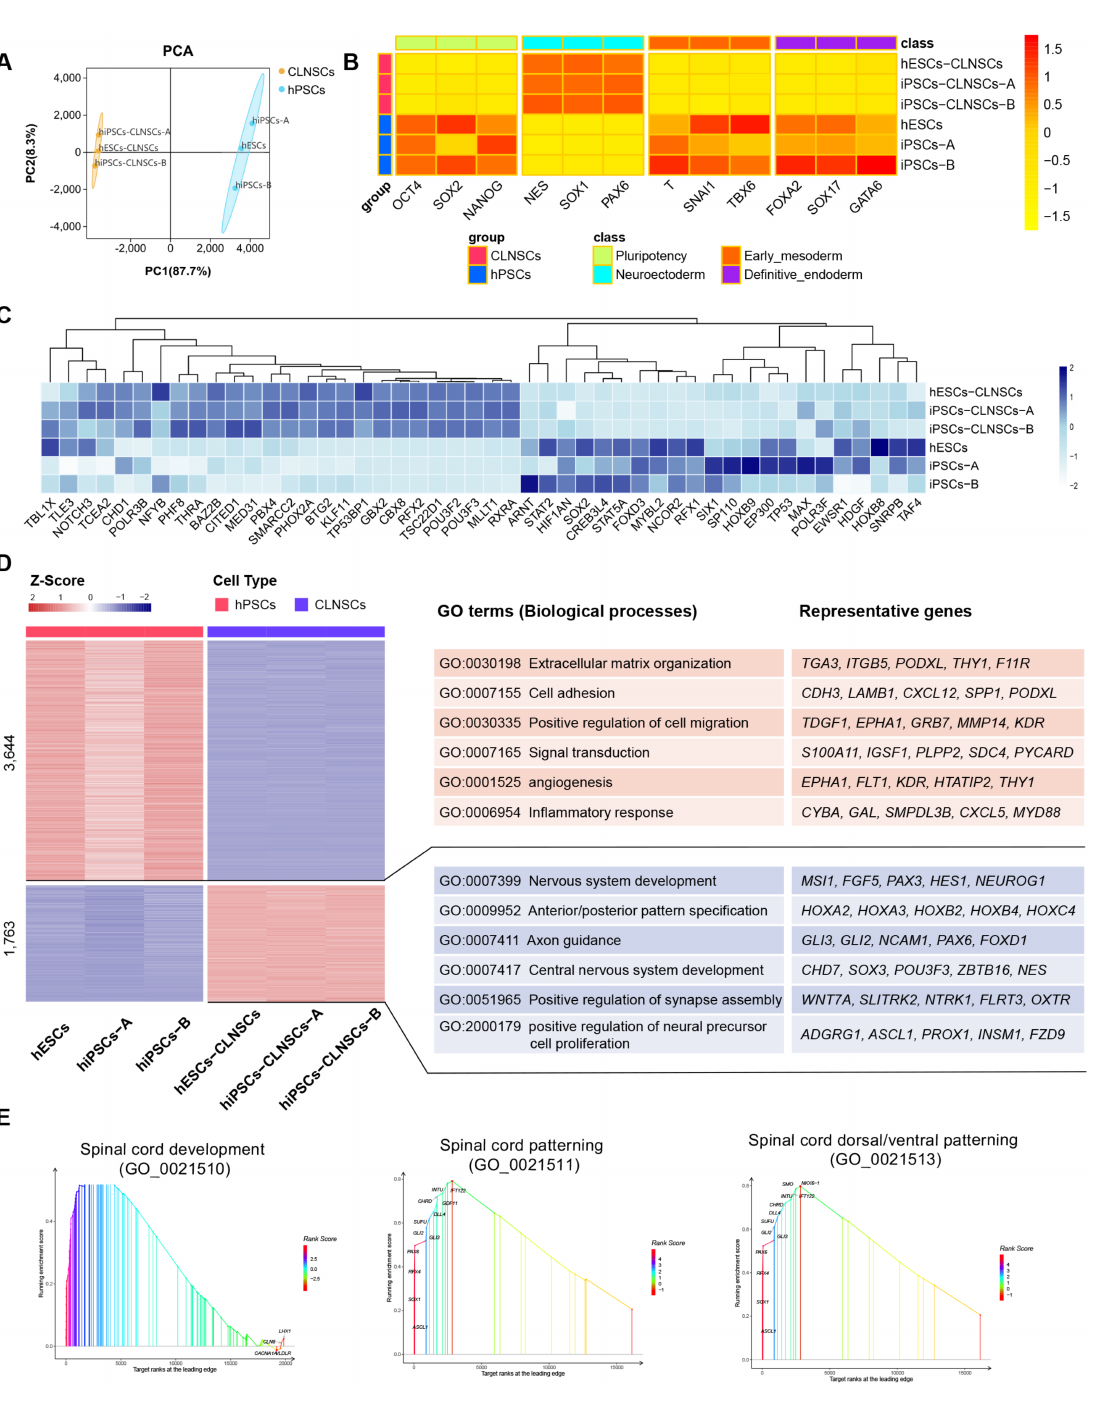
Figure 4. The transcriptome changes in CLNSCs, pre- and post- neural differentiation. ( A ) PCA plot showing hPSCs and CLNSCs. ( B ) Heatmap shows the gene expression levels of pluripotent and three lineage markers in hPSCs and CLNSCs; the scale bar shows Z-score values. ( C ) Heatmap shows the gene expression levels of TFs that are essential for neuroectoderm in CLNSCs and hPSCs; the scale bar shows Z-score values. ( D ) DGEs in CLNSCs compared with hPSCs were represented by heatmap (|log2 (fold change)| > 1, FDR < 0.05), the scale bar shows Z-score values. Significantly enriched biological processes, GO terms, and the representative up-regulated genes in each GO term are listed on the right; the top GO term is enriched in hPSCs and the bottom GO term is enriched in CLNSCs. ( E ) Spinal cord development-associated GO terms in CLNSCs were significantly enriched by GSEA. The peak in the graph divides the curve into two sides. The first side is called the leading edge, and the genes on this side are leading targets that are worth exploring. The abscissa is target ranks, which indicates the ranking of targets, and ordinate is the enrichment